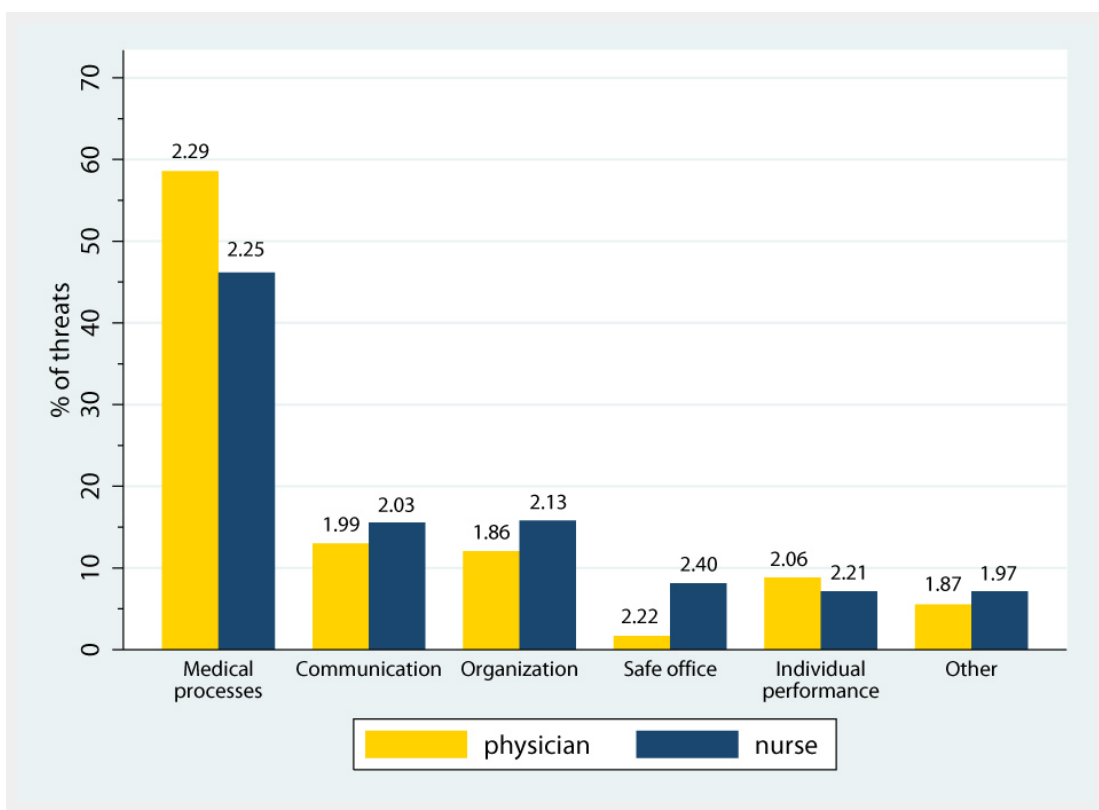
Figure 2 Frequency of cited threats by top-level category and occupational group (n = 936 threats). Numbers on top of bars indicate the mean priority assigned to that category (higher numbers indicate higher